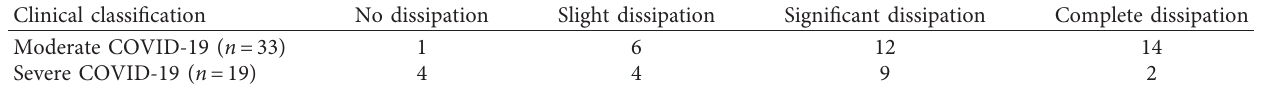
Table 4: Degree of residual lesion dissipation in 52 patients with COVID-19 at the first